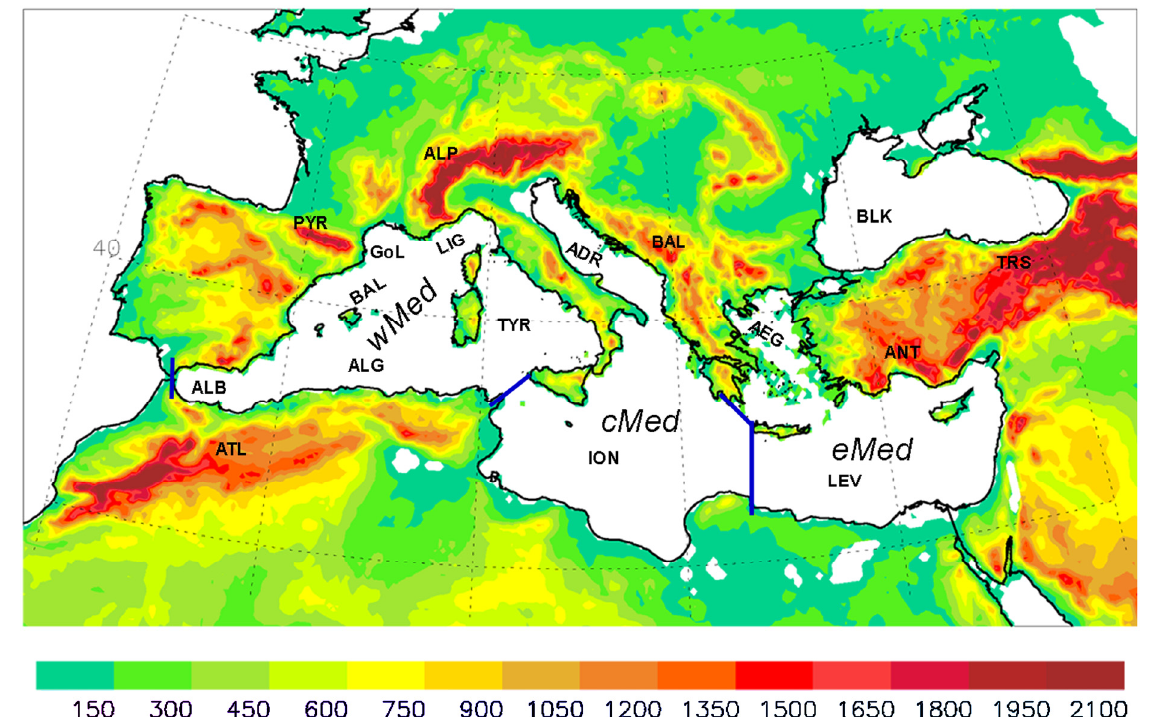
Figure 1. Orography of the studied area (in meters). wMed: The western Mediterranean basin consists of the Alboran (ALB), the Algerian (ALG), the Balearic (BAL), the Ligurian (LIG) and the Tyrrhenian (TYR) sub-basins; cMed: the central Mediterranean basin consists of the Adriatic Sea (ADR) and the Ionian sub-basin (ION); and eMed: the eastern Mediterranean basin consists of the Aegean Sea (AEG) and the Levantine sub-basin (LEV); BLK: Black Sea; ALP: Alps; ATL: Atlas; BAL: Balkan; PYR: Pyrenees; ANT: Anatolian and TRS: Taurus Mountains. Blue-solid lines indicate limits between western, central and eastern Mediterranean